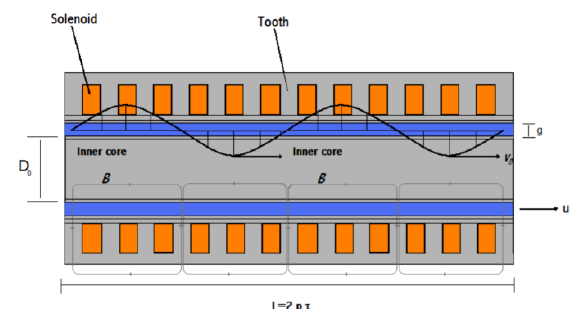
Fig. 5. Conceptual representation of the ALIN pump. The black curve schematically represents the magnetic induction (B) as a traveling wave of velocity vs. Liquid metal is shown in blue (reproduced from [16])